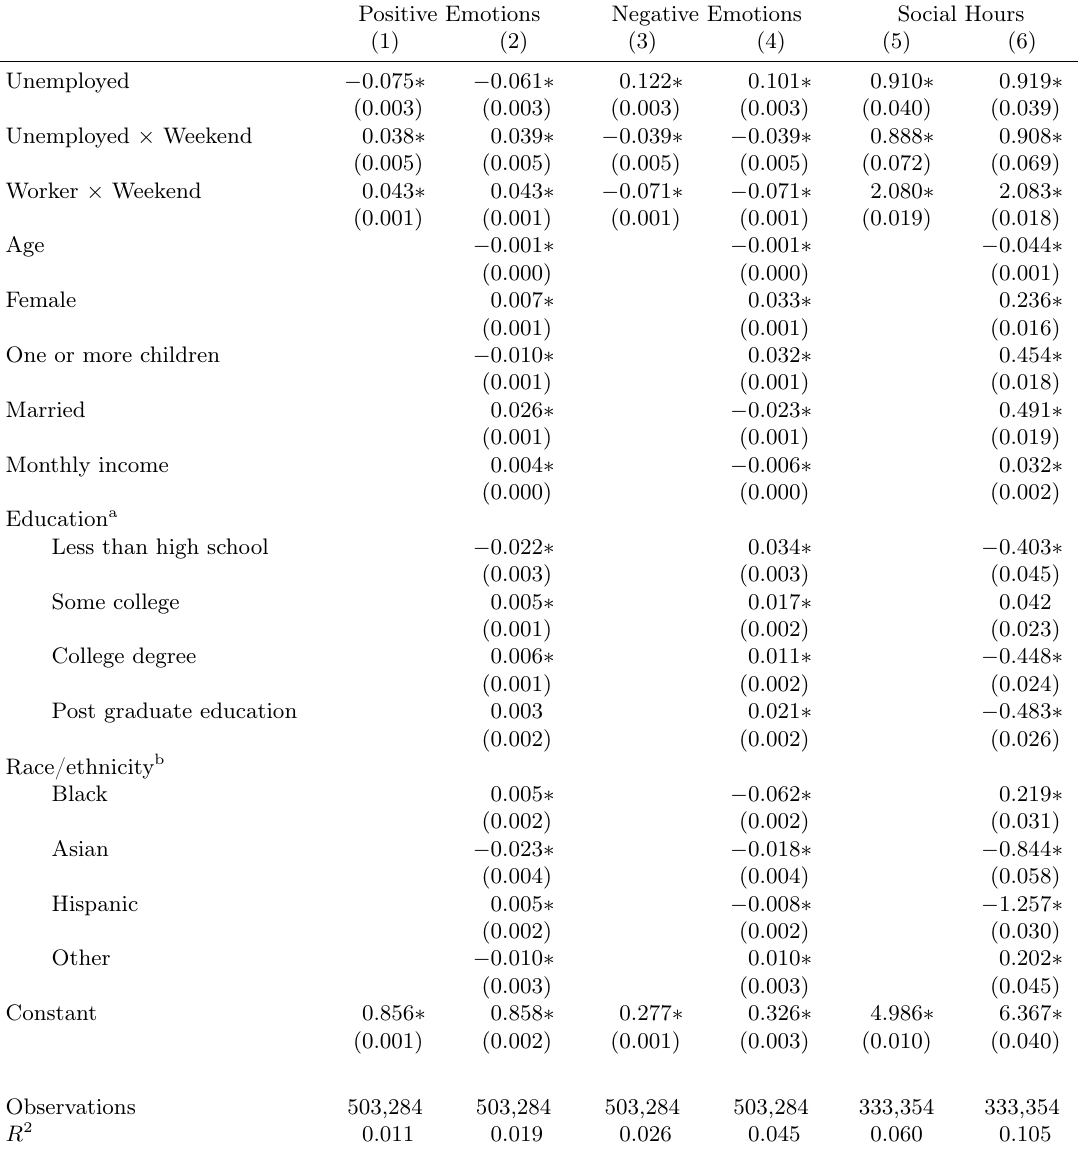
Table 2: Determinants of Positive Emotions, Negative Emotions, and Social Hours Positive